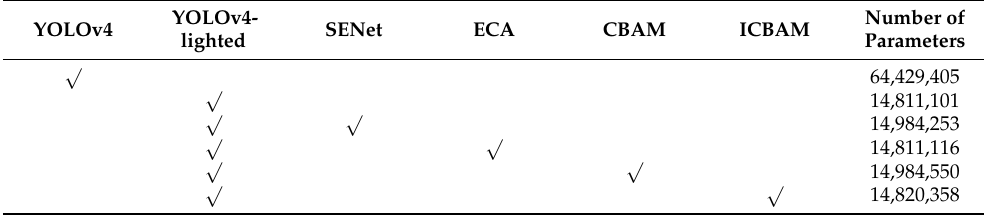
Table 2. Comparison of model